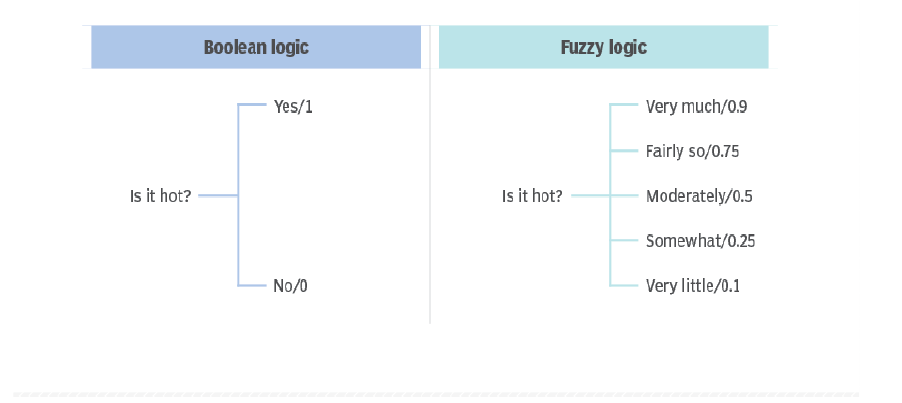
Figure 2 – Boolean logic Vs fuzzy logic Рис. 2 – Булева логика против нечеткой